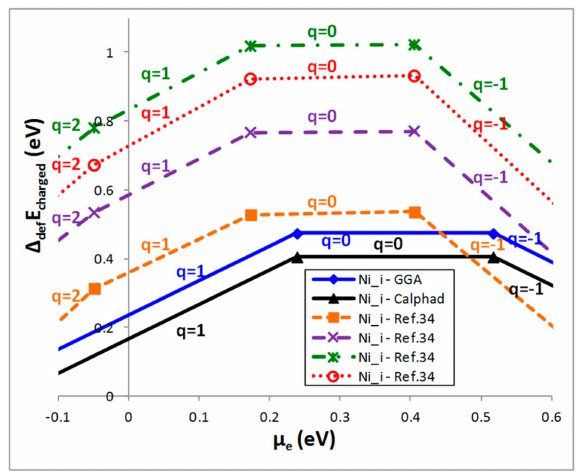
Figure 3. Evolution of ∆ def E charged for Ni i defects with the chemical potential of the electrons for different values of the charge q calculated for one defect in a 2 × 2 × 2 supercell taking into consideration the phase diagram calculated in GGA or assessed with the Calphad